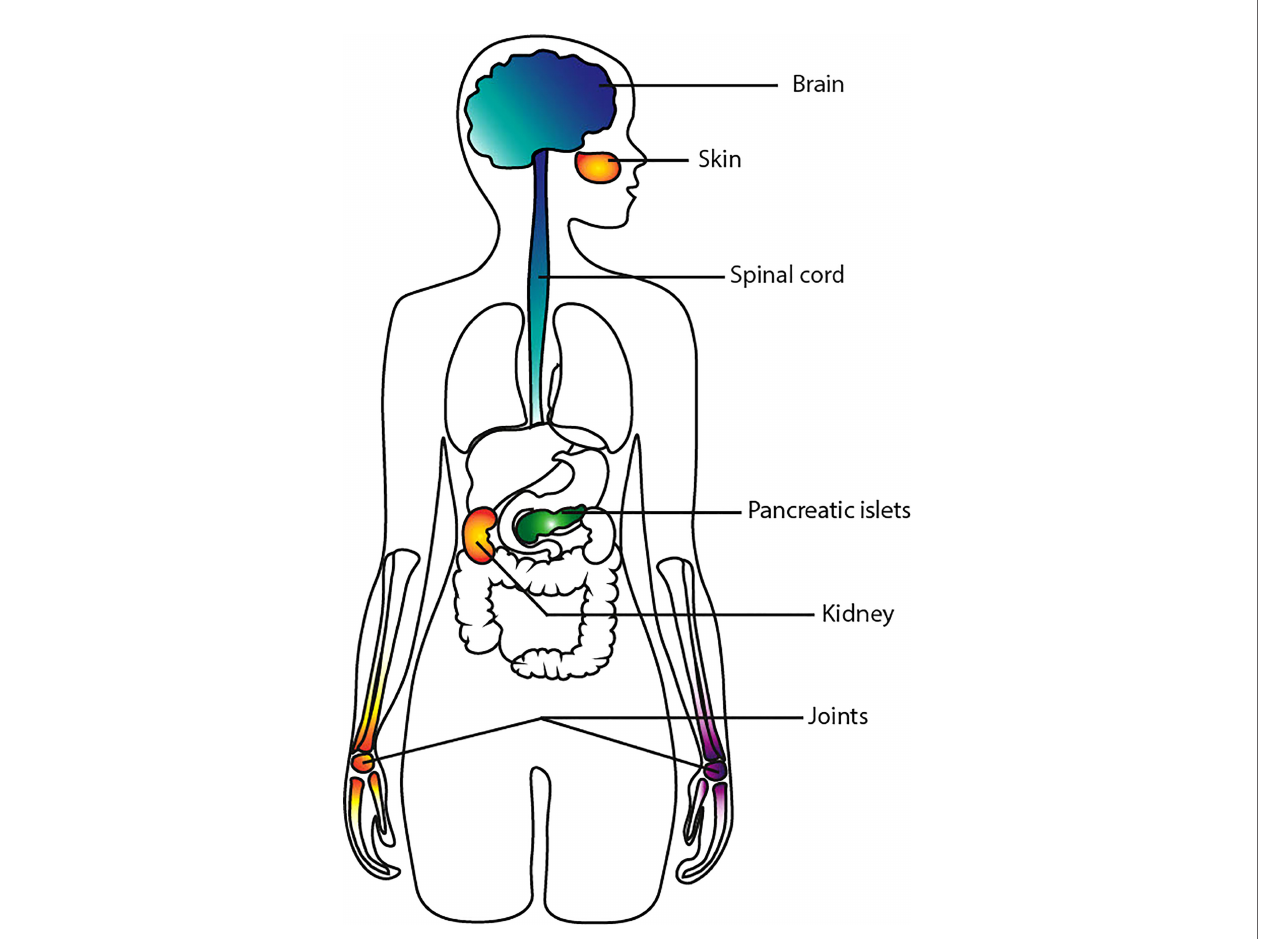
FIGURE 1 | Primary site of onset. This illustration shows the primary site of initiation of the autoimmune process in RA, SLE, MS, and T1D. RA is represented in purple, SLE in orange, MS in blue and T1D in